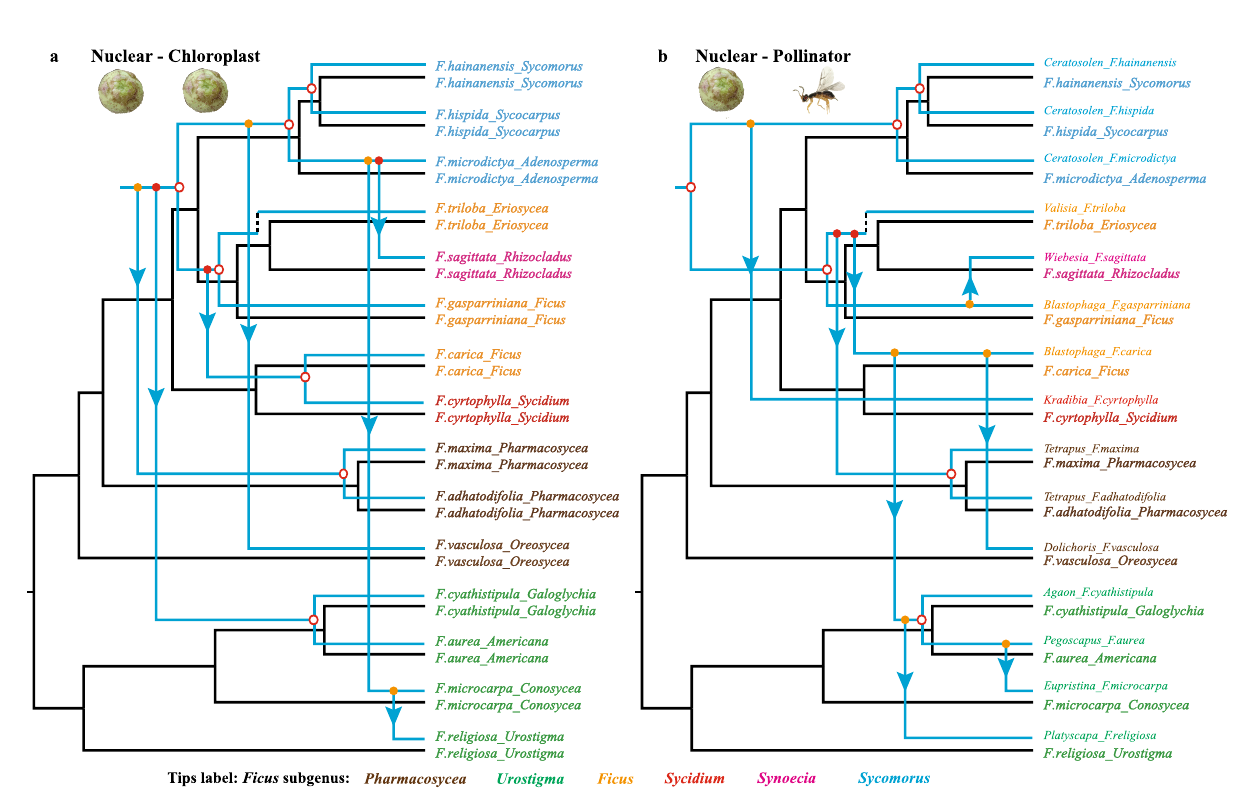
Fig. 5 Co-phylogenetic reconciliations and detail evolutionary events inferred among main fi g clades. One of the equally most parsimonious co- phylogenetic reconciliations inferred with JANE under optimal cost setting for each of two kinds of phylogeny pairs: between Ficus phylogenies based on nuclear and chloroplast genomes ( a ) and between Ficus nuclear-genome phylogeny and the phylogeny of associated pollinators ( b ). Ficus and pollinator phylogenies used were indicated with symbol of fi gs and wasp separately. The black tree represents the nuclear genomic phylogeny in both a and b , and the blue trees represent chloroplast phylogeny ( a ) or pollinator phylogeny extracted from Cruaud et al. 20 ( b ). Tip labels indicate fi g species and section in Ficus phylogeny, wasp genus, and associated host species in the pollinator phylogeny. Subgenus information (tip name color) of sampled species are also shown. Hollow red circles represent codivergence events in a and cospeciation events in b ; solid colored circles and arrow lines represent events of associate switch (chloroplast switch) in a and of pollinator switch in b , while fi lled orange dots indicate existence of another potential switch location in the phylogeny that has equal cost, and a fi lled red dot means that all other potential switch locations have higher cost; dashed lines represent associate events of chloroplast loss (in a ) or of pollinator extinction (in b ). Refer to Supplementary Table 8 and Supplementary Fig. 5a for key Ficus taxa, they represent the two currently most plausible, if